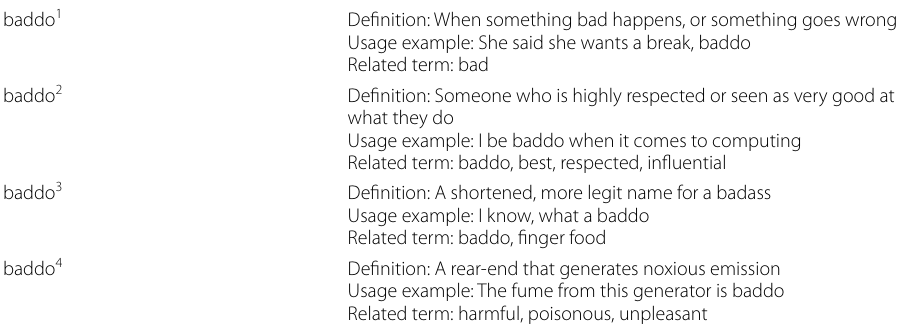
Table 6 Senses from the IKB baddo 1